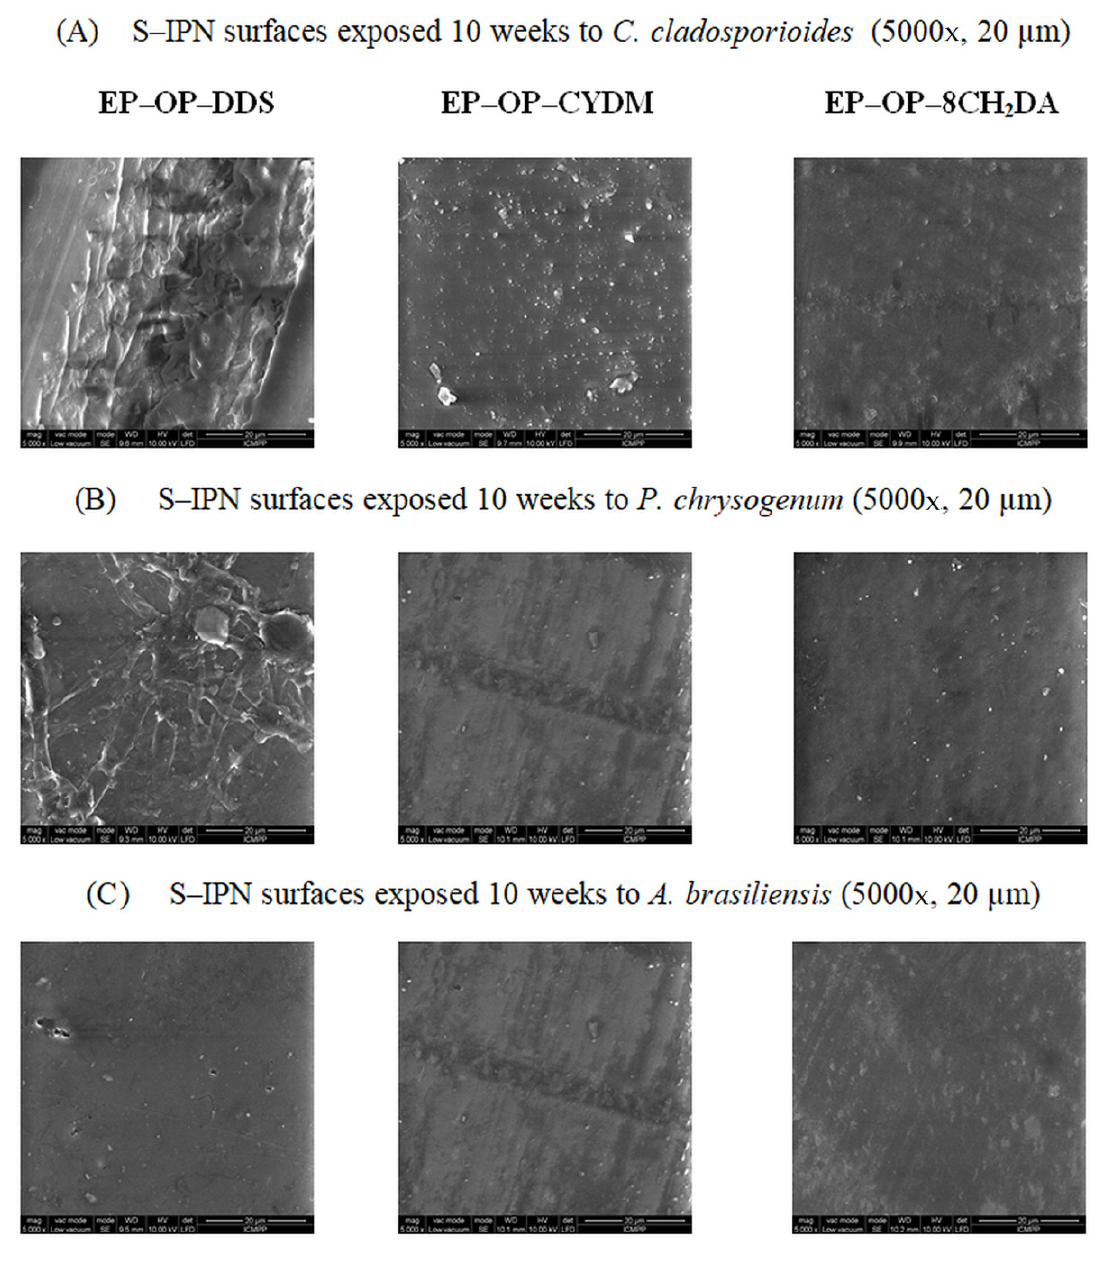
Figure 14. SEM micrographs of the S–IPNs surfaces after fungal attack.